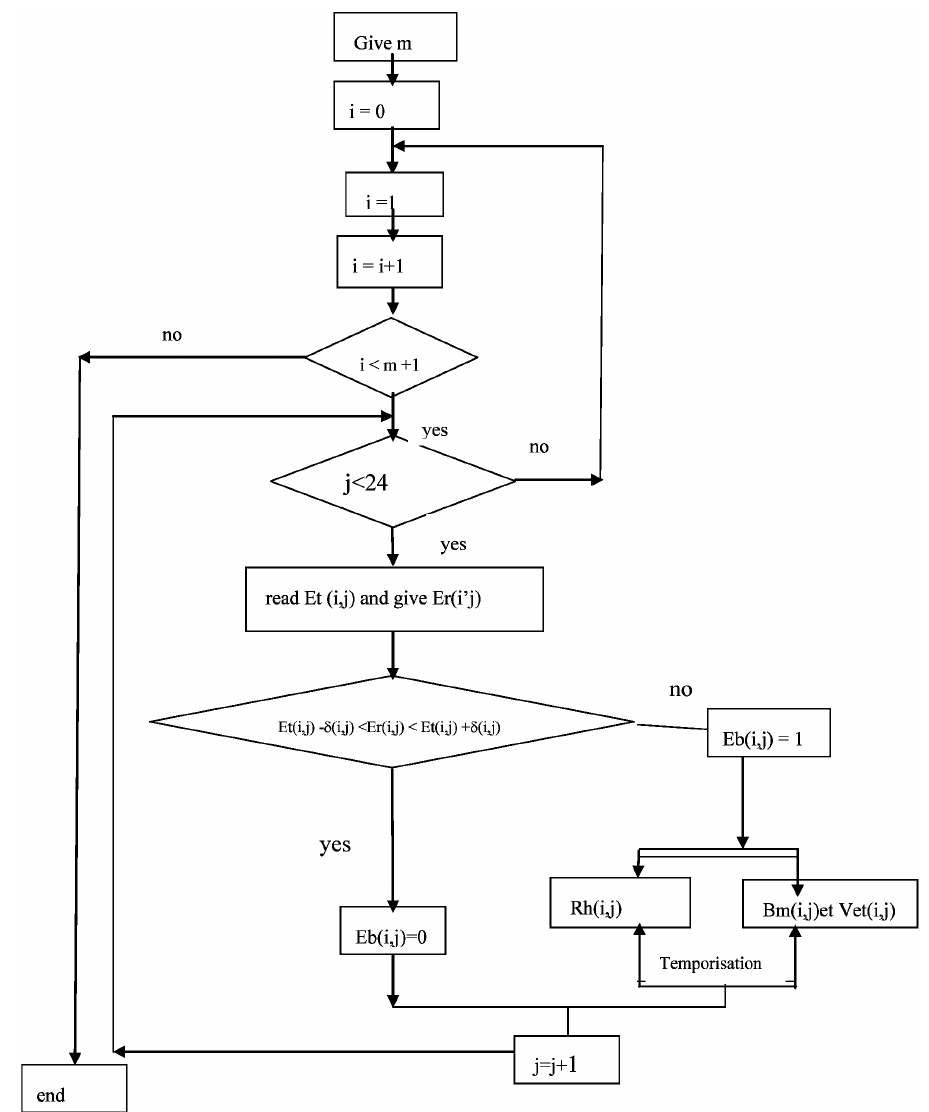
Figure 4. Algorithm of optimal leaks